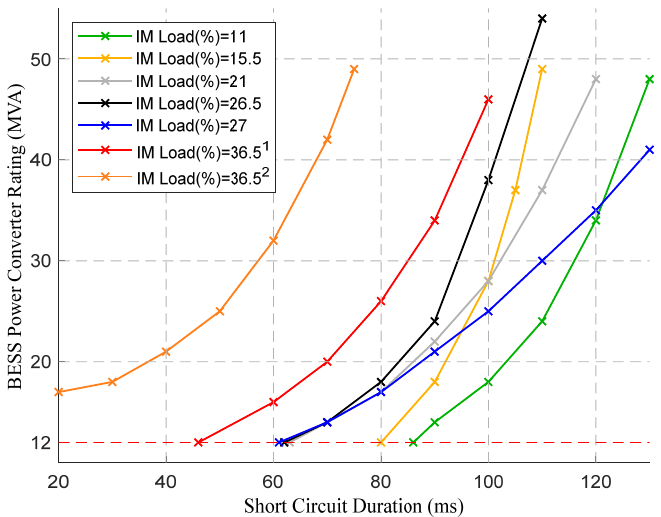
Figure 13. BESS power converter sizing vs. fault duration as a function of the IM load percentage.